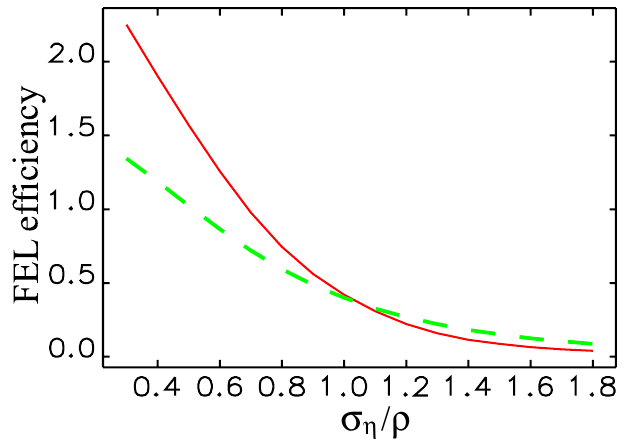
(cid:3) versus = (cid:2) (cid:5)P sat beam (cid:1) (cid:6) =(cid:5) from the (cid:9) ^ (cid:9)